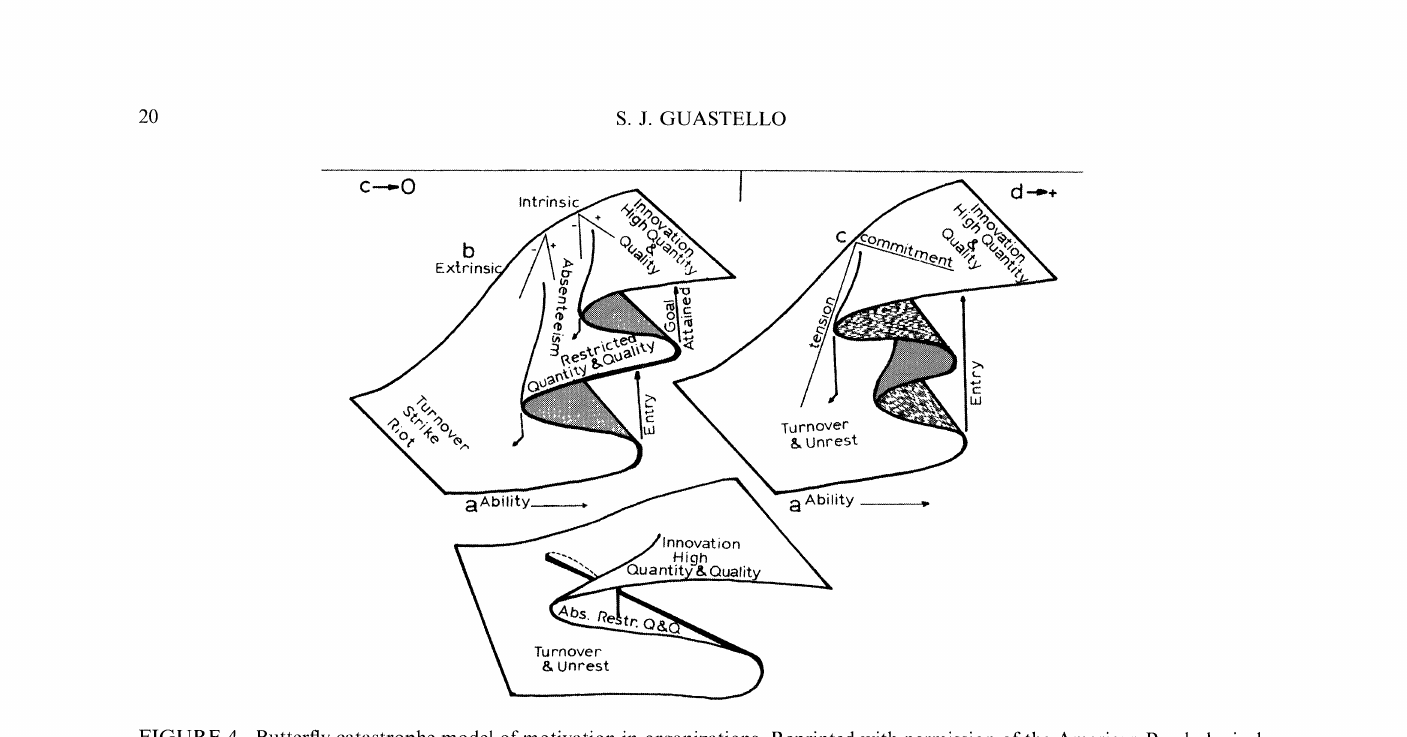
FIGURE 4 Butterfly catastrophe model of motivation in organizations. Reprinted with permission of the American Psychological